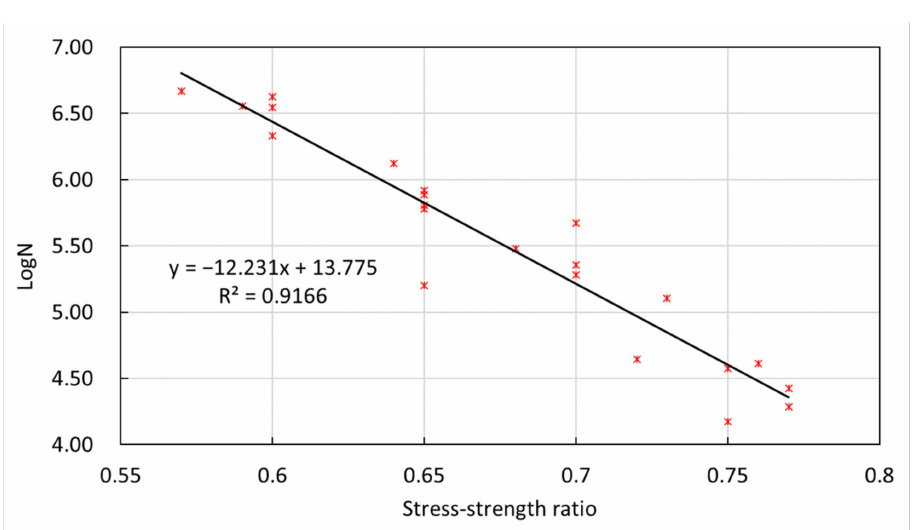
Figure 10. Fitting curves of LFSG fatigue test in different stress–strength